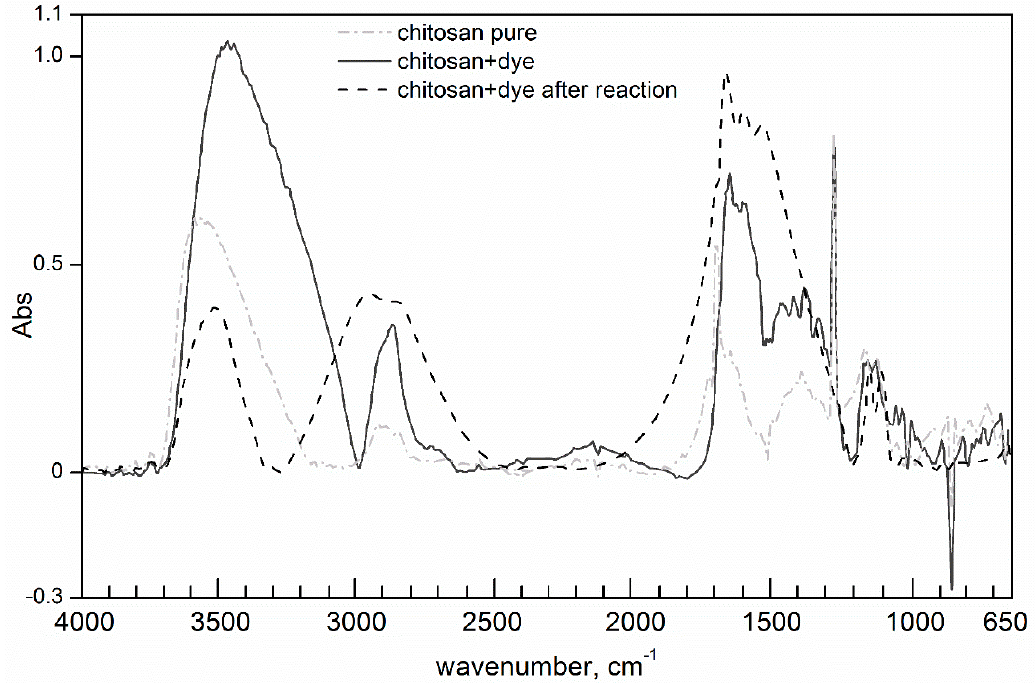
Figure 3. FTIR spectra for the chitosan before and after photosensitizer immobilization.